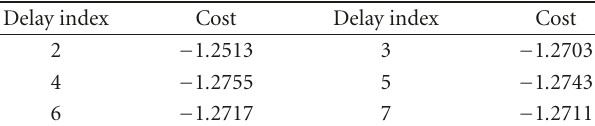
Table 1: Minimal cost using GPS for di ff erent delays around